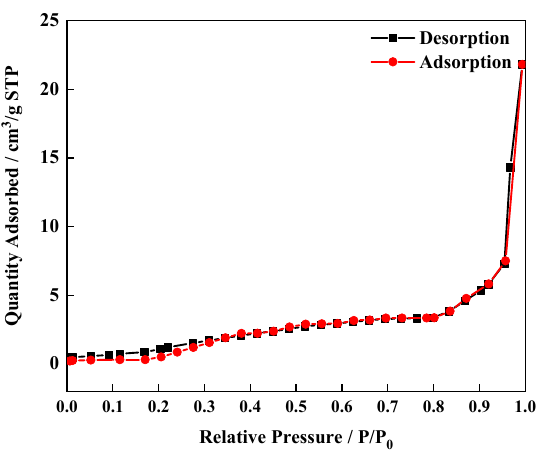
Figure 6. The N 2 adsorption desorption isotherms of Eu 0.075 Tb 0.925 -MOF.